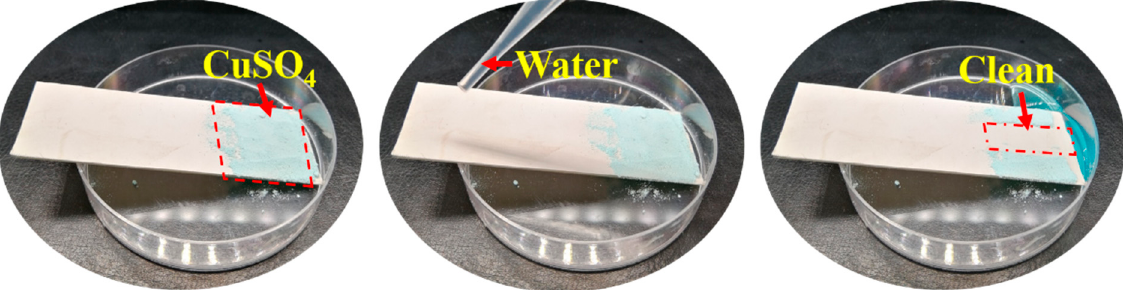
12 of 17 Figure 9. ( a ) Image of five kinds of droplets on the SBS/PDA/SiO 2 fibrous membrane surface. ( b ) Image of honey drops rolling off the SBS/PDA/SiO 2 fibrous membrane. ( c ) Images of the SBS fibrous membrane and the SBS/PDA/SiO 2 fibrous membrane that were immersed in ink and taken out. As shown in Figure 10, a layer of CuSO 4 particles is spread on the SBS/PDA/SiO 2